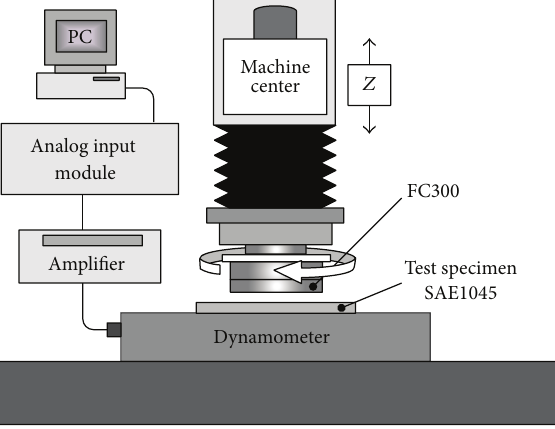
Figure 1: Schematic diagram of experimental setup.